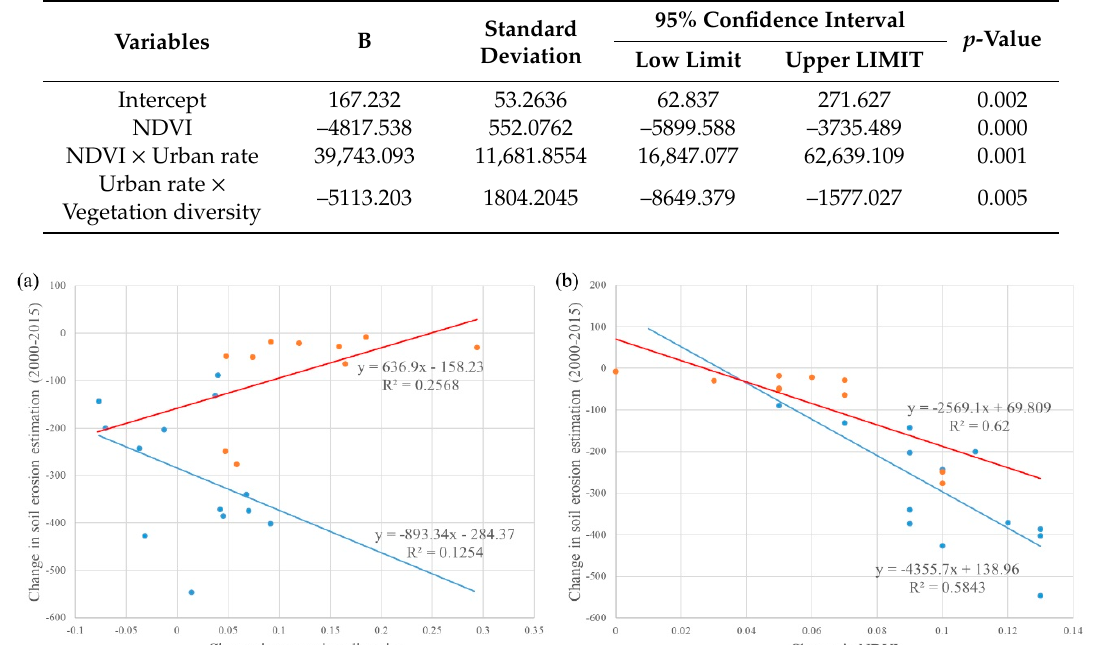
Table 5. Parameter estimation of Generalized Linear Model.